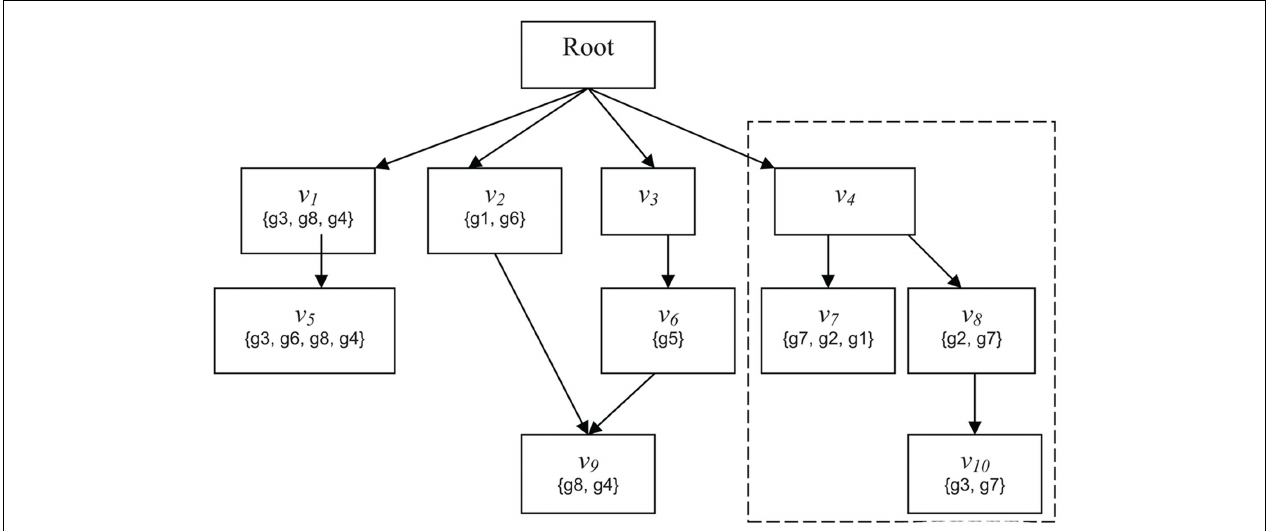
FIGURE 1 | Schematic of GO. Abstract example of an ontology illustrating the principles of the GO DRAG and the scoring functions Boxes labeled with Root